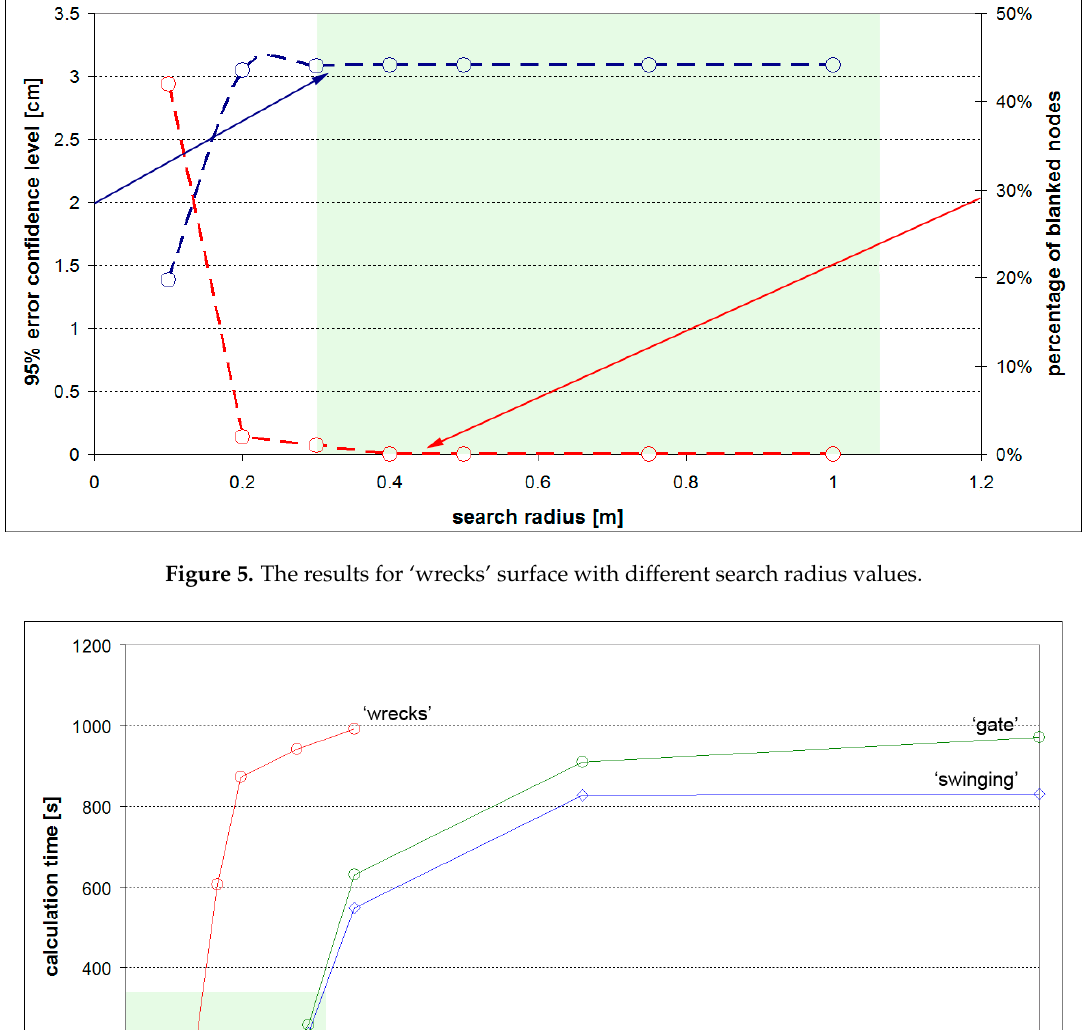
Figure 4. The results for the ‘swinging’ surface with different search radius values.